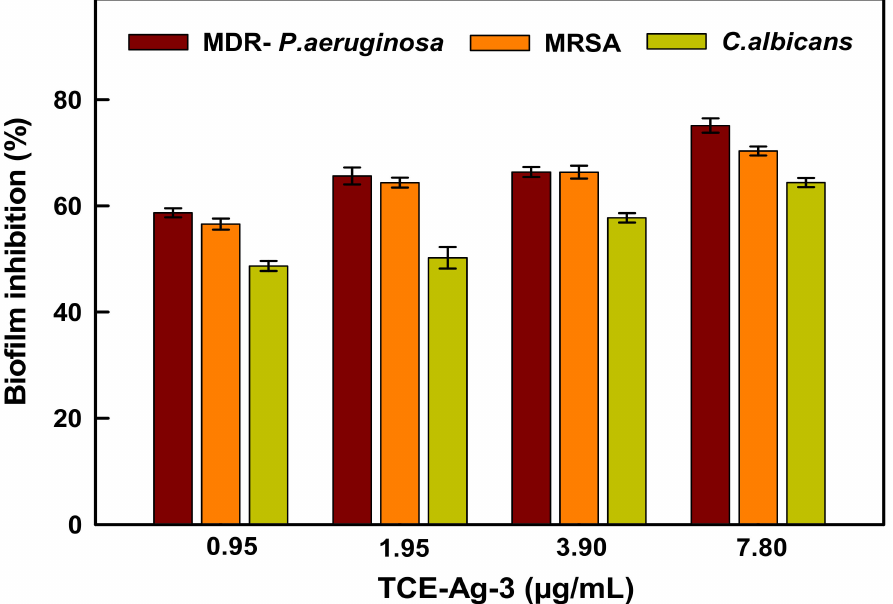
Figure 10. Reduction in the formation of biofilm in the presence of 0.95, 1.95, 3.90, and 7.80 µ g/mL concentrations of TCE-Ag-3 NPs. The error bars represent standard deviations of triplicate